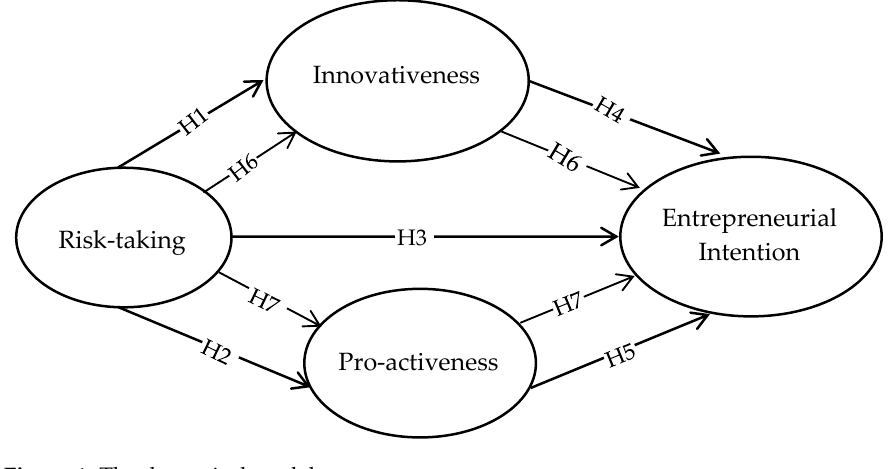
Figure 1. The theoretical model